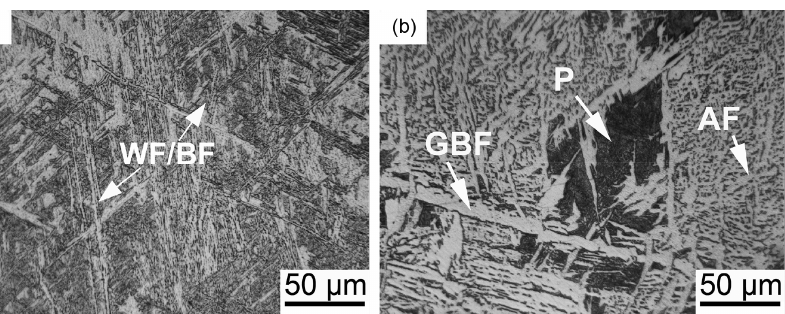
Figure 7: The micrographs and composi- tions of typical nonmetallic inclusions in steels (a) MN4; (b, c and d) MN5.